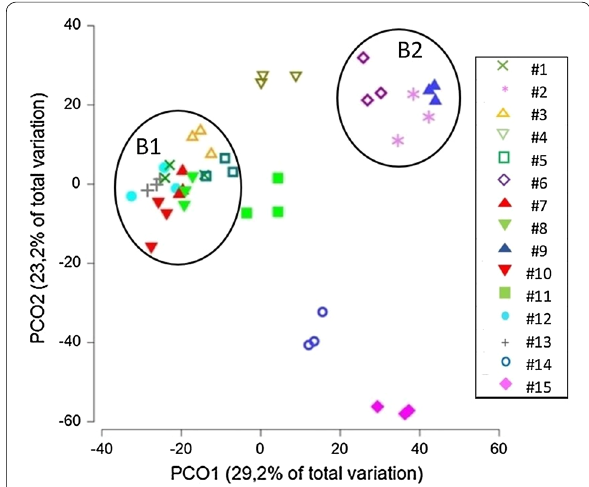
Fig. 2 Principal coordinates analysis of the ARISA‑fragment patterns obtained for the investigated technical plants (numbering as assigned in Table 1). Three samples per plant were processed and analyzed independently. Bacterial clusters 1B and 2B are indicated by circles